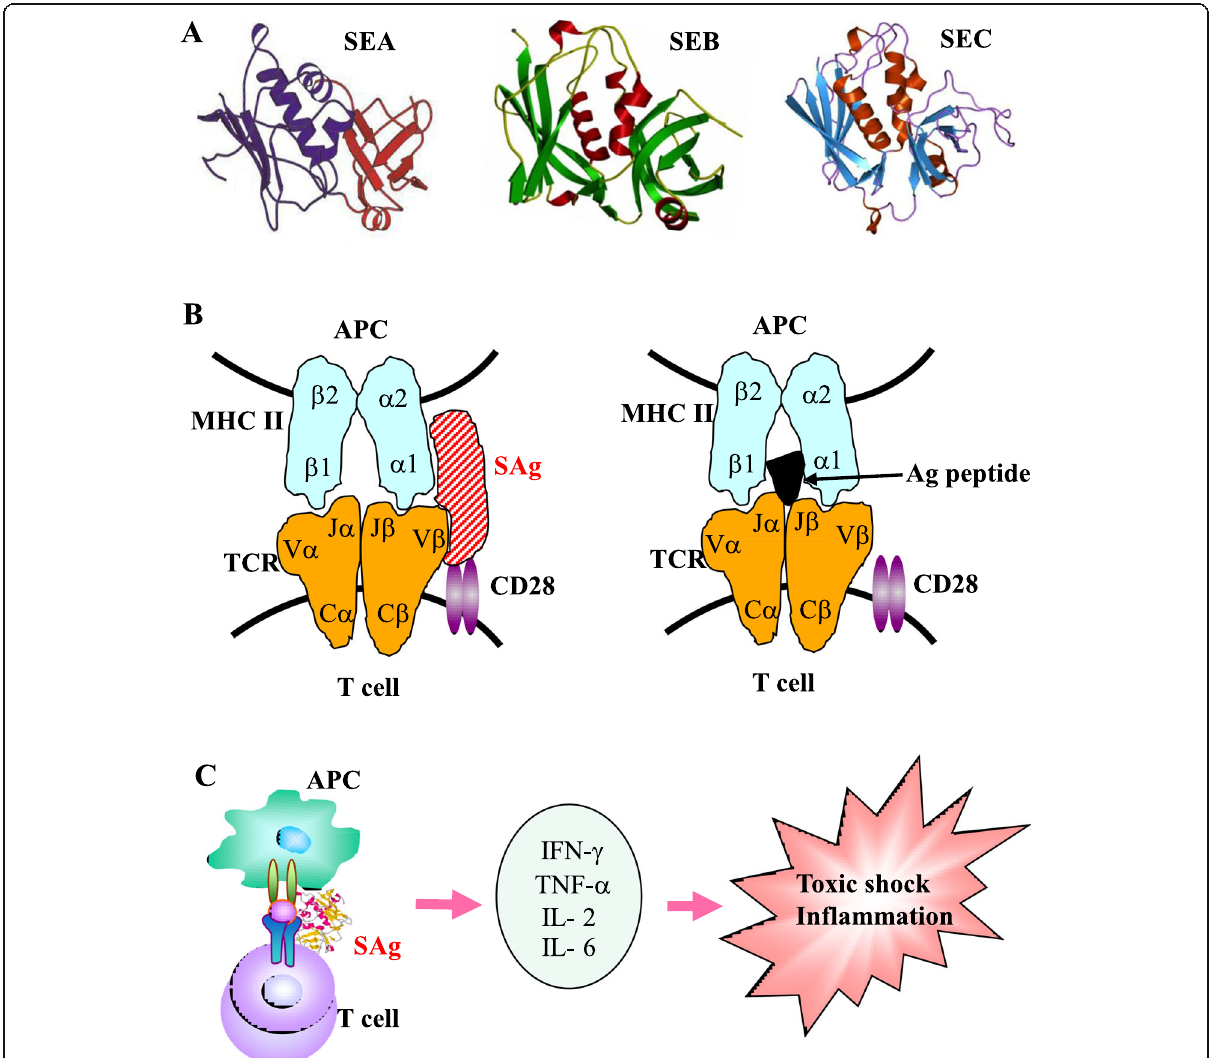
Fig. 2 Characteristics and activities of SAg toxins. A Three-dimensional structures of SEA, SEB and SEC as representative of SAg toxins. B Diagram of superantigen (left) and normal antigen (right) bind to MHC class II of APC and T-cell receptor, CD28 molecules. C Superantigenic activities of SAg toxins, that induce massive cytokine production and subsequently cause inflammation and toxic shock in humans and animals. This figure was prepared and modified from Hu et al. (2014, 2018). SE, staphylococcal enterotoxins; APC, antigen-presenting cells; MHC, major histocompatibility comlex; TCR,